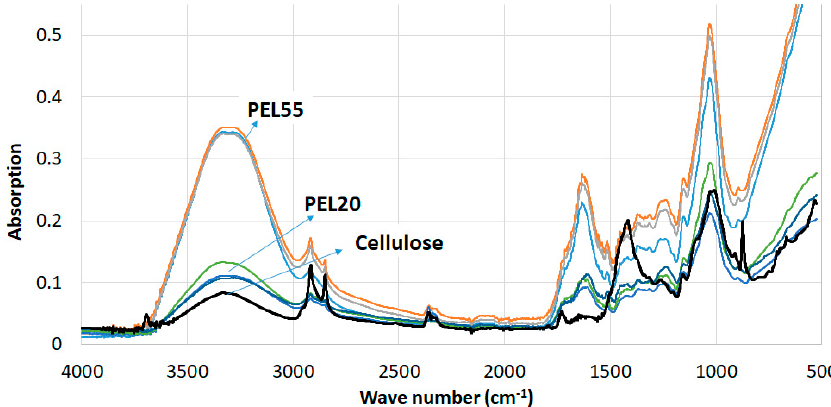
Figure 8. FT-IR spectra of medium peat fibers containing two water contents [24].